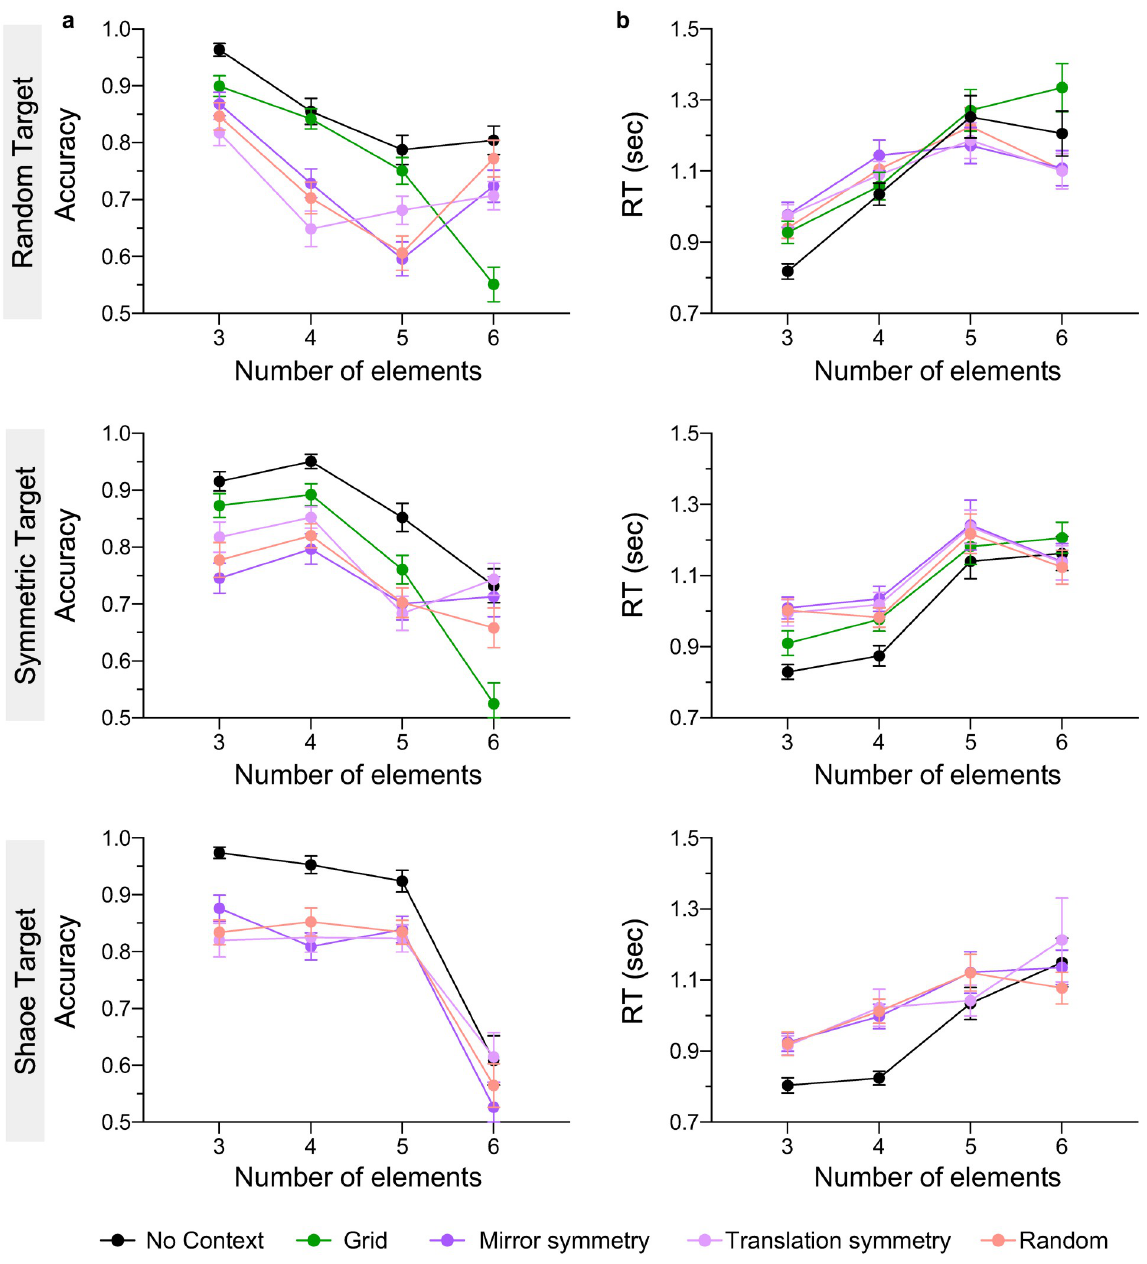
Fig 6. Experiment 4 results (context effects). (a) Accuracy and (b) reaction time are plotted as a function of number of elements and context configuration (no context, grid, mirror symmetric, translation, random), for different type of target arrangements: Random target (top panels), symmetric target (middle panels) and shape target (bottom panel). The error bars indicate standard error of the mean ( ± 1